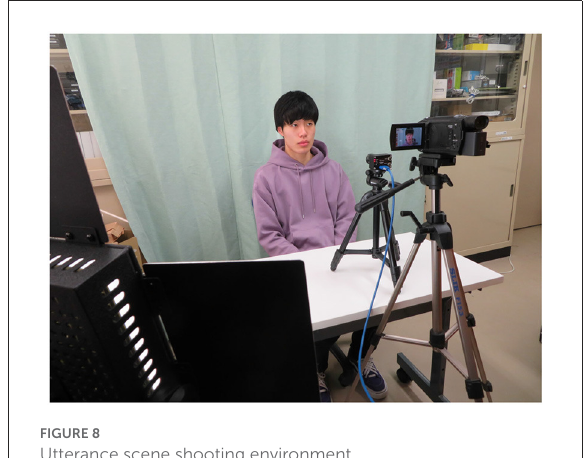
FIGURE8 Utterance scene shooting environment.